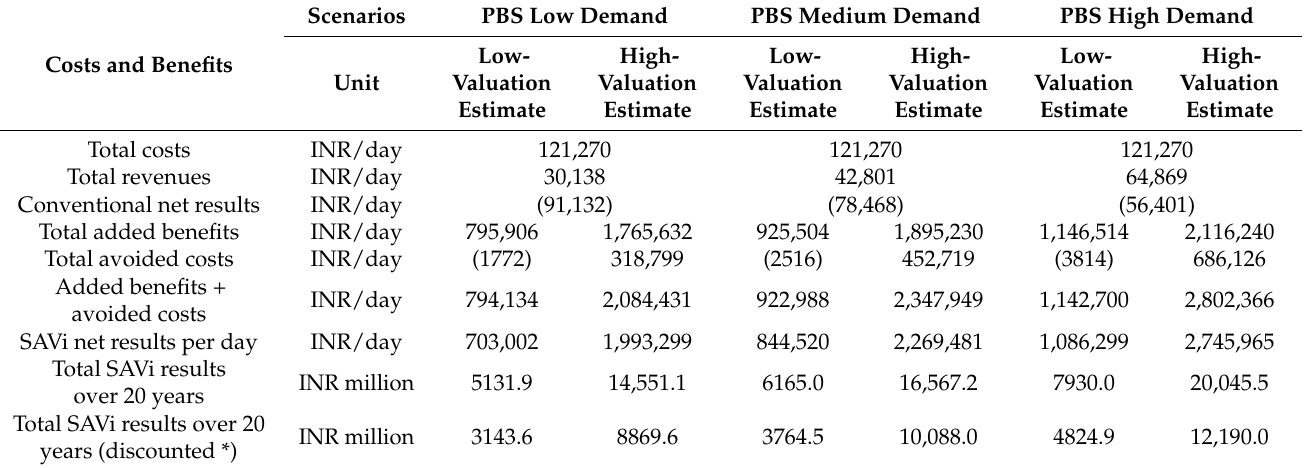
Table 6. Integrated CBA, undiscounted daily values (in INR) per PBS scenario based on a project period of 20 years